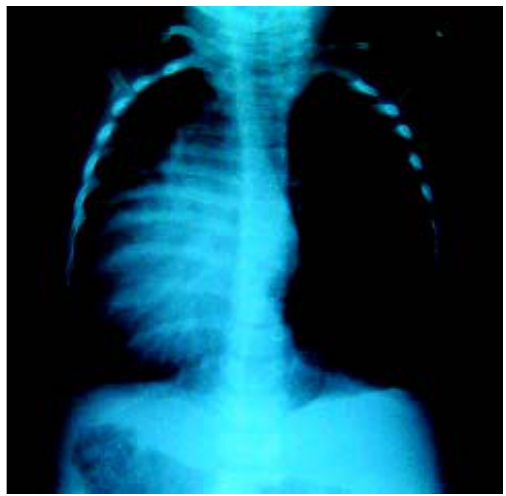
Fig. 2 – Radiograma demonstrando a presença de situs inversus visceral e dextrocardia.